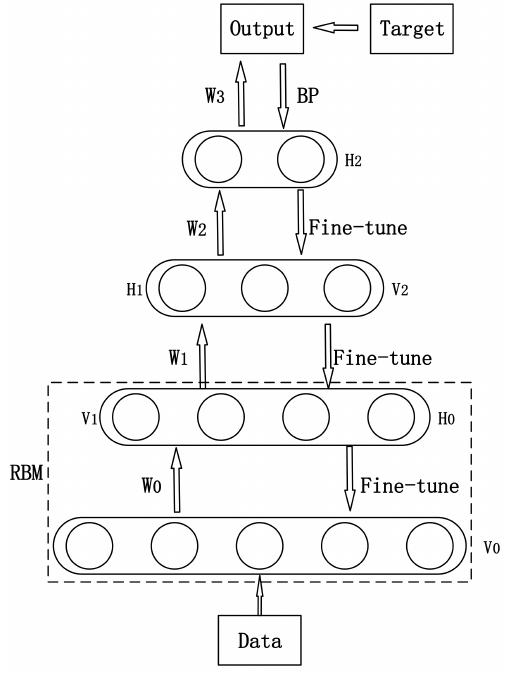
Figure 3. Structure of Deep Belief Network